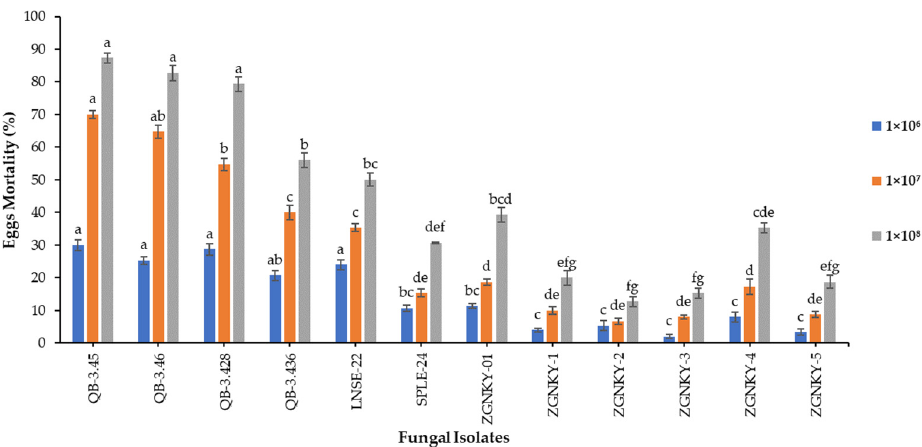
Figure 1. Mortality of FAW eggs infected with B. bassiana isolates. Means followed by the same letter of alphabets are not significantly different according to Tukey’s test at p < 0.05.